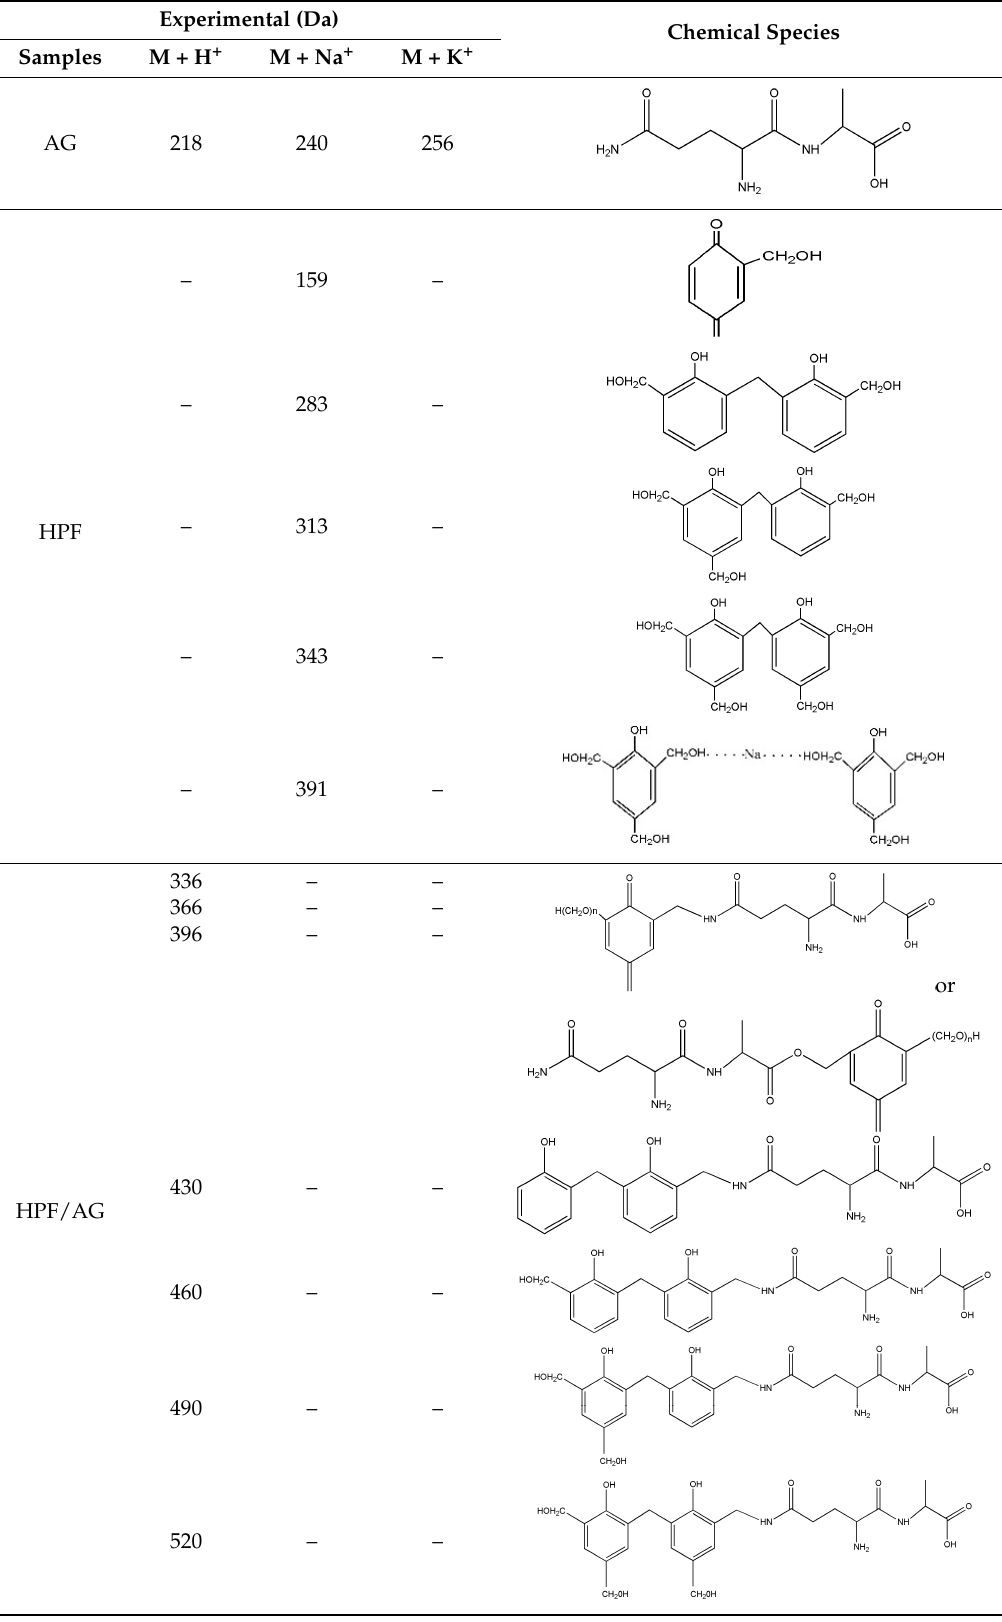
Table 1. The main ion peaks of ESI-MS and their assignments.